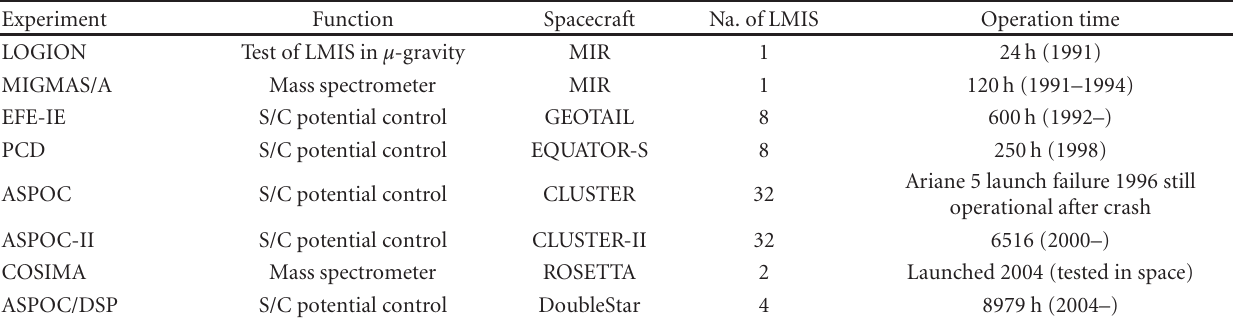
Table 1: Space experience of indium LMIS (up to September 2009).